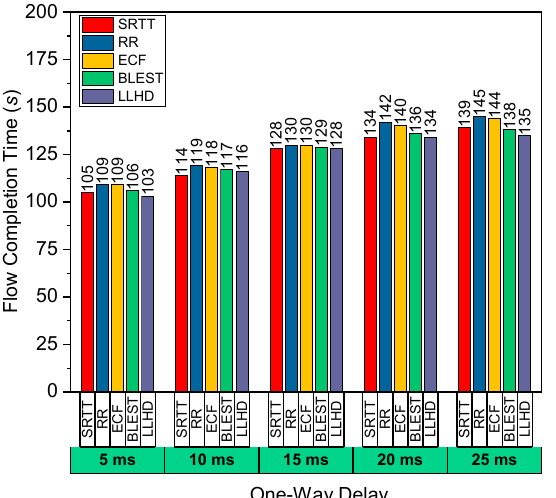
Figure 4. Performance evaluation of the considered schedulers in terms of FCT for variate path delay in Scenario #3.